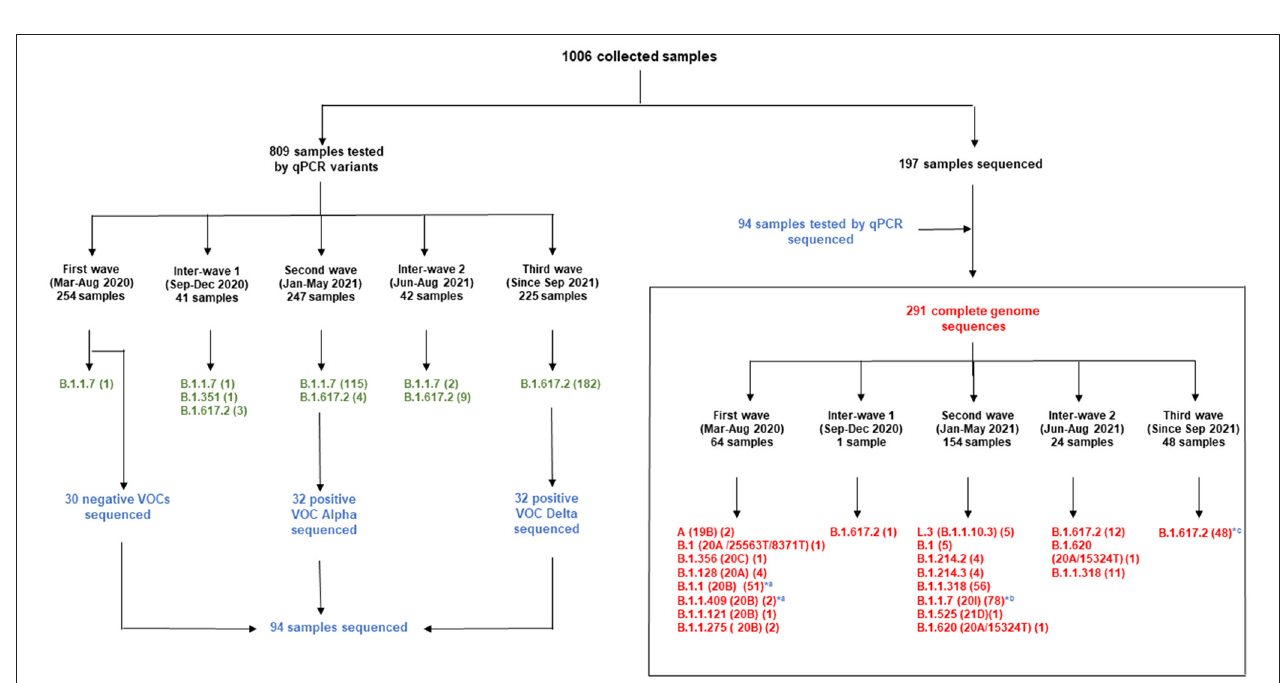
FIGURE 4 | Distribution of samples screened by qPCR during the different waves and whole genome sequencing. qPCR results are in green; Samples first tested by qPCR and sequenced are in blue; Complete genome sequences are in red. *, genomes from samples tested by qPCR and sequenced; a , first wave; b , second wave; c , third